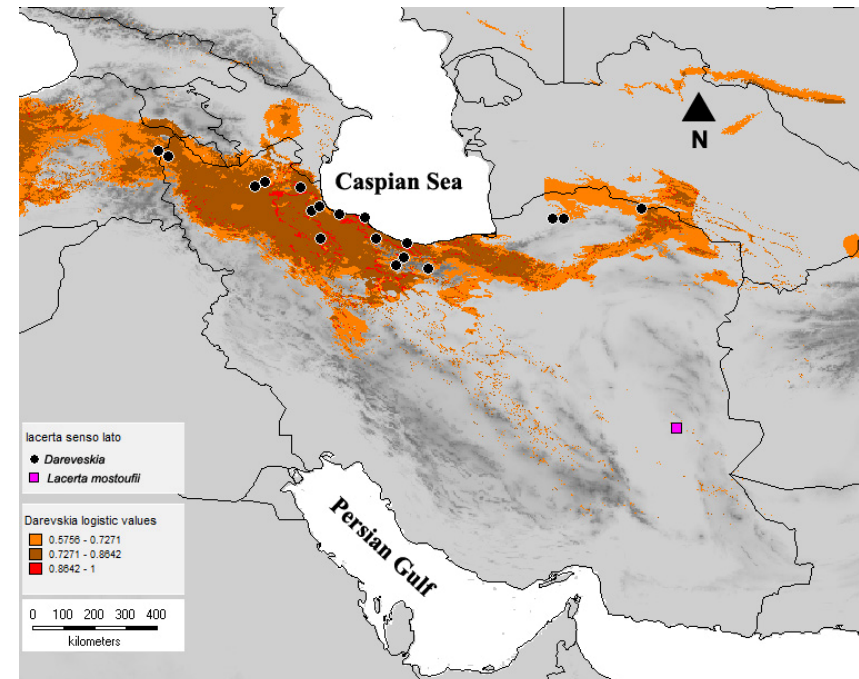
F IGURE 2. Potential distribution of the genus Dareveskia in Iran. Colors on the map indicate different suitability values. Black dots represent known records of the genus Dareveskia and Pink square represents type locality of Lacerta mostoufii